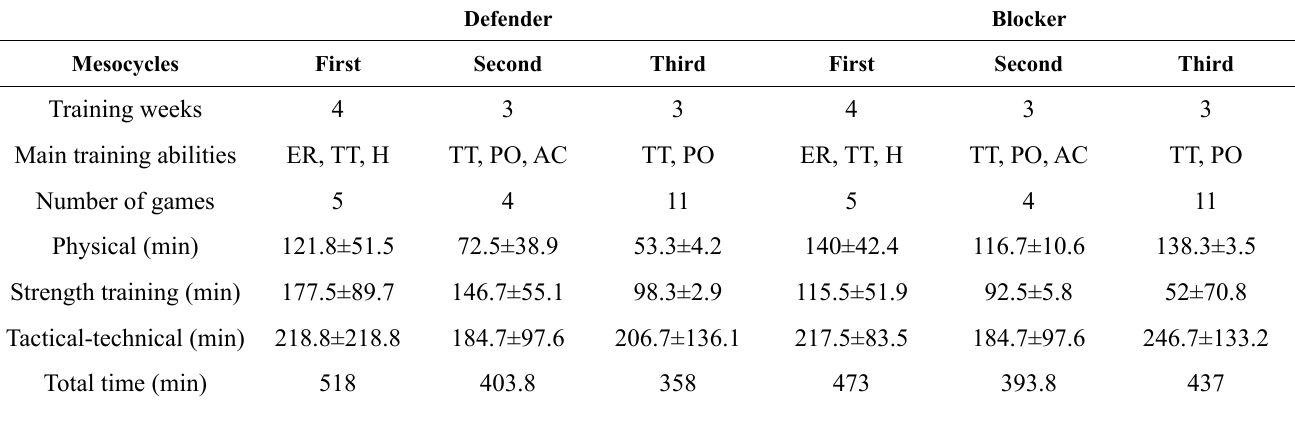
Table I - Description of each volleyball player’s training weeks, main training abilities, number of games and training variables. Defender Blocker Mesocycles